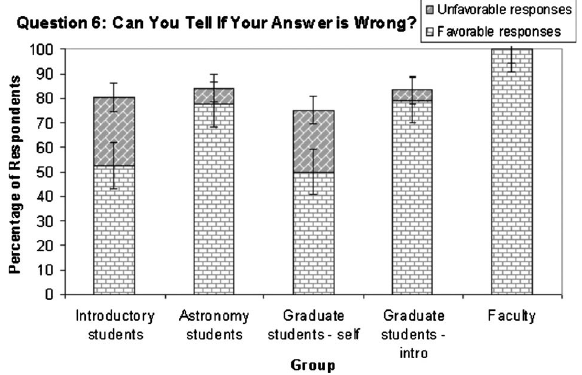
FIG. 3. Histogram showing favorable (cid:1) disagree (cid:2) and unfavor- able (cid:1) agree (cid:2) responses for survey question (cid:1) 11 (cid:2) . The histogram shows that many more graduate students disagreed that they rou- tinely use equations to calculate answers even if they are nonintui- tive for introductory-level problem solving than graduate-level problem solving. Almost equal percentage of introductory physics students agreed and disagreed with the